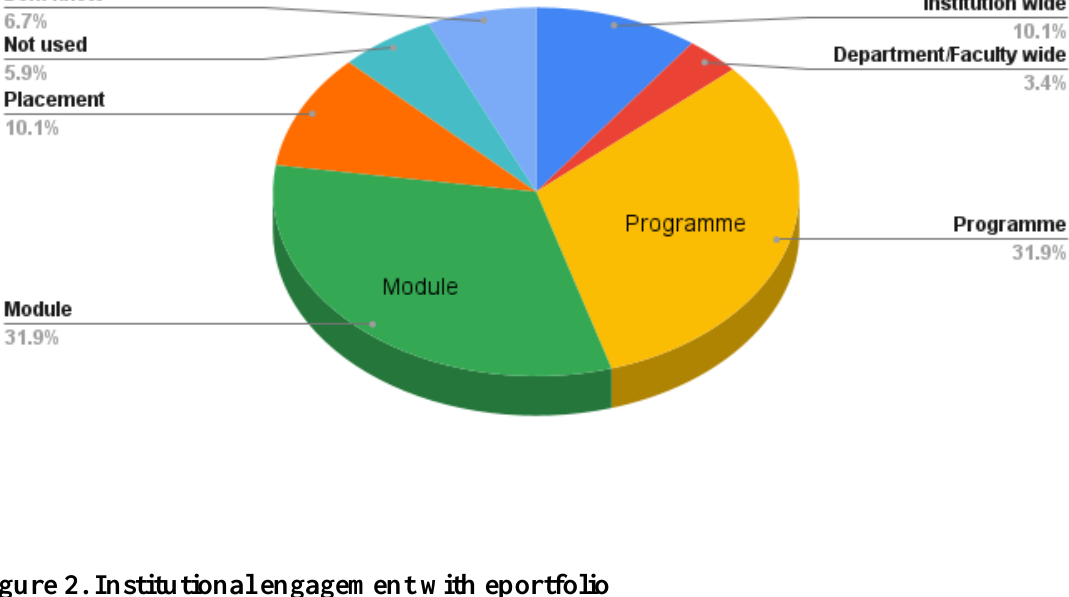
Institutional leadership for eportfolio